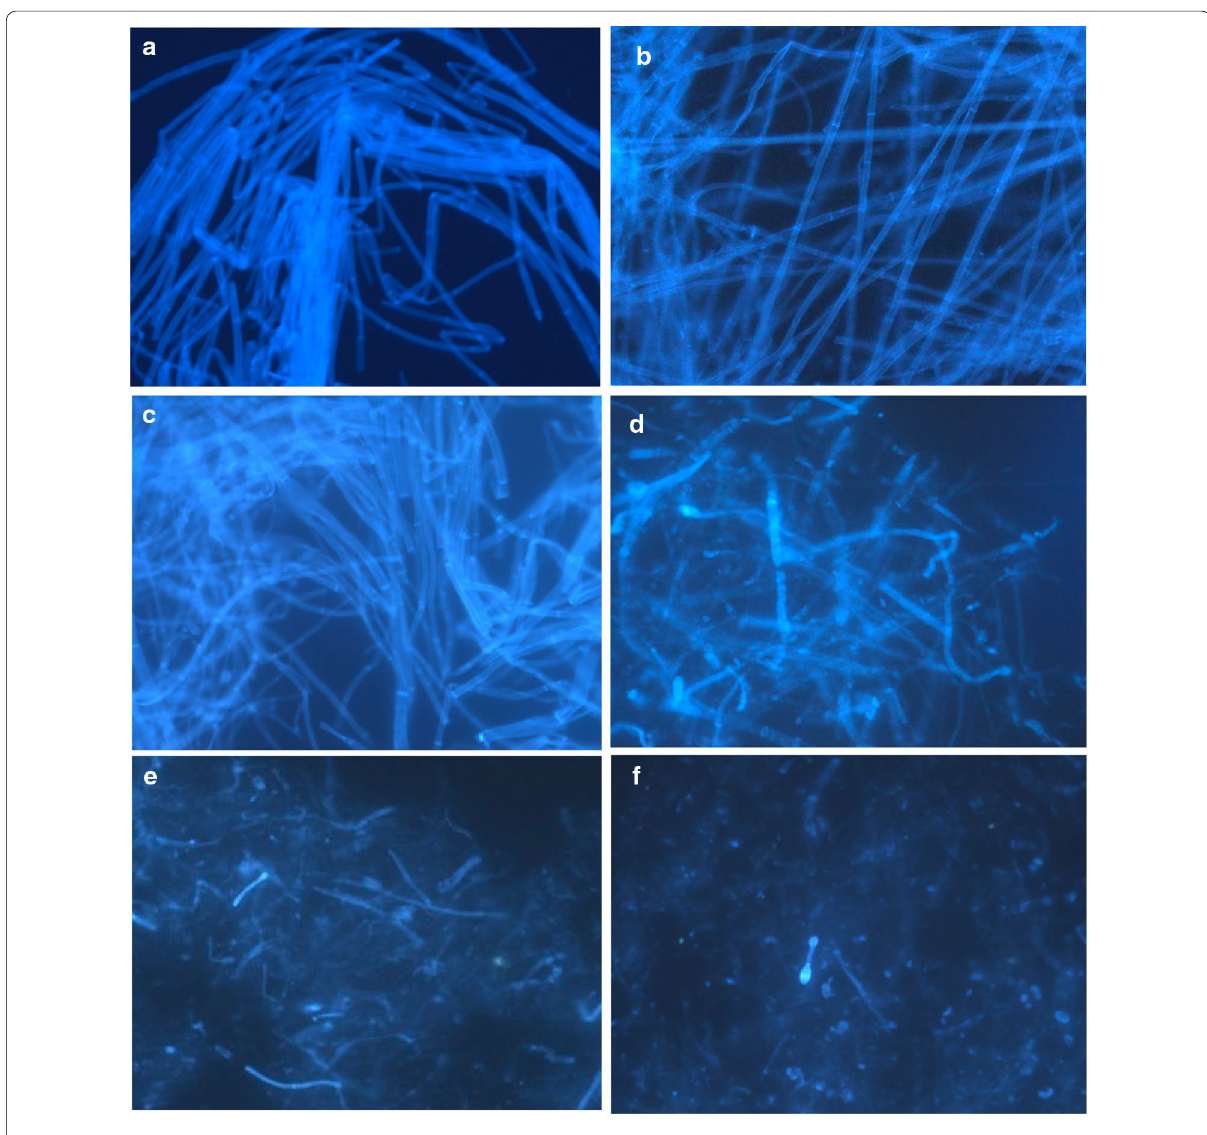
Fig. 2 Fluorescence photomicrographs of mycelial cells of F. oxysporum f. sp. spinaciae strain M2-1 anaerobically incubated in the PYG broth at 25 °C. a Intact mycelial cells before the start of the incubation; b after the control incubation of the pathogen alone (without strain H110) for 16 days; c – f co-incubated with strain H110 for 1 day ( c ), 2 days ( d ), 3 days ( e ), and 7 days ( f ). Live mycelial cells of strain M2-1 on agar sections of PDA were inoculated into the PYG broth and the agar sections taken out from the culture tubes on each sampling day were used for the microscopic observation. Bar, 30